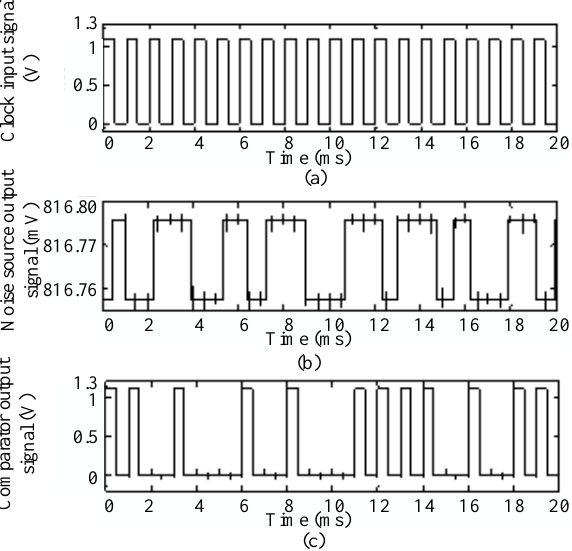
Figure 8. Analog system post-simulation waveform.